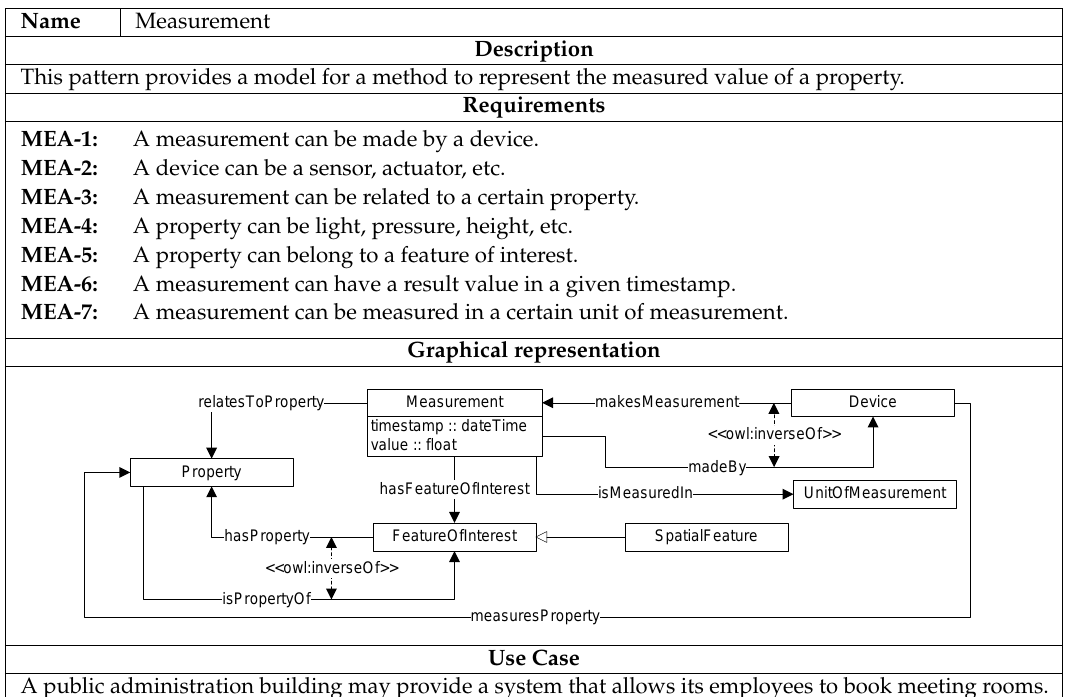
Table 10. Measurement